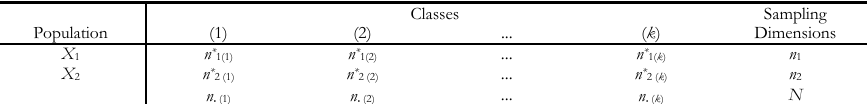
Absolute frequencies after a permutation of data